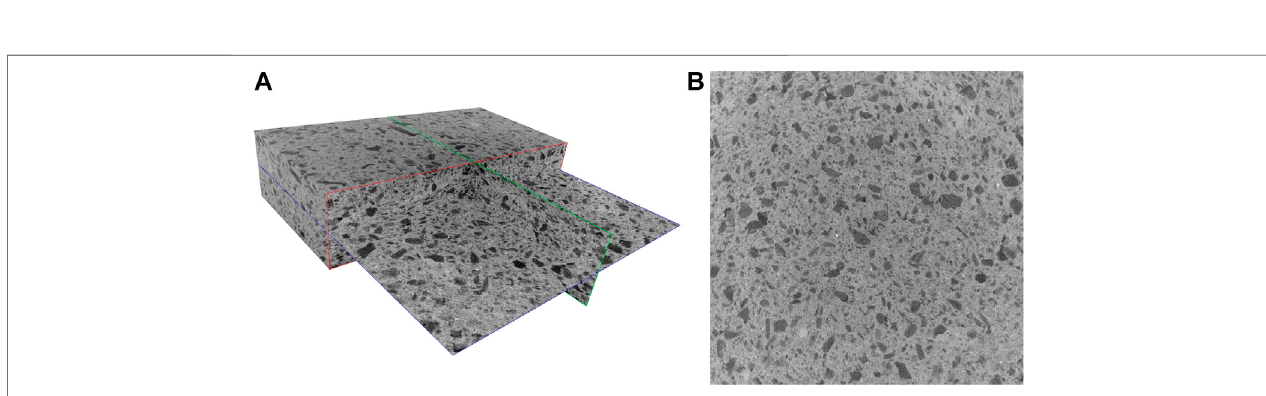
FIGURE 3 | 3D microCT render (A) and representative slice (B) of the Composite B30%. The volume has a dimension of 20.6 × 20.6 × 4.8 mm 3